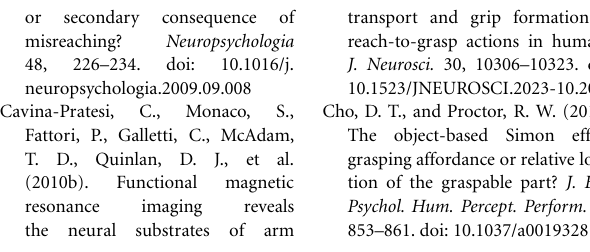
Figure S1 | Relationship between EMG parameters of the first dorsal interosseous (FDI) muscle and index-finger button press reaction time (RT). Participants were required to perform a simple button press with their index finger in response to a visual cue. EMG was recorded from the FDI during task performance. The same EMG analysis was performed as described in the main text. The plots here show the relationship between RTs recorded using a button press and between EMG max (A) and onset (B) in one representative participant. Correlation coefficients (Pearson’s r) were averaged for each individual across two hand positions, and then across 10 participants (C) . On average, both latencies of EMG maximum (max time) and onset showed strong correspondence with RT values ( p < 0 . 0001). The area under the EMG envelop (area) also showed a significant relationship with RT values ( p < 0 . 05), although to a much reduced extent. EMG amplitude (mV) at maximum latency (max amp) and mean amplitude during EMG baseline (mean baseline) didn’t show any significant relationship with button press RT. Based on these findings, EMG maximum and onset latencies have been identified as the most relevant EMG parameters as proxies for RT. Error bars show s.e.m. Data was taken from Makin et al. (2009), Experiment